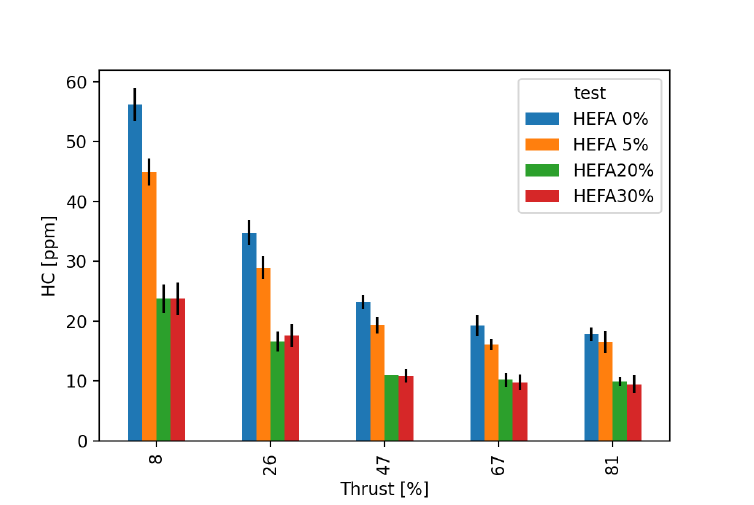
Figure 22. GTM-140/HEFA: HC